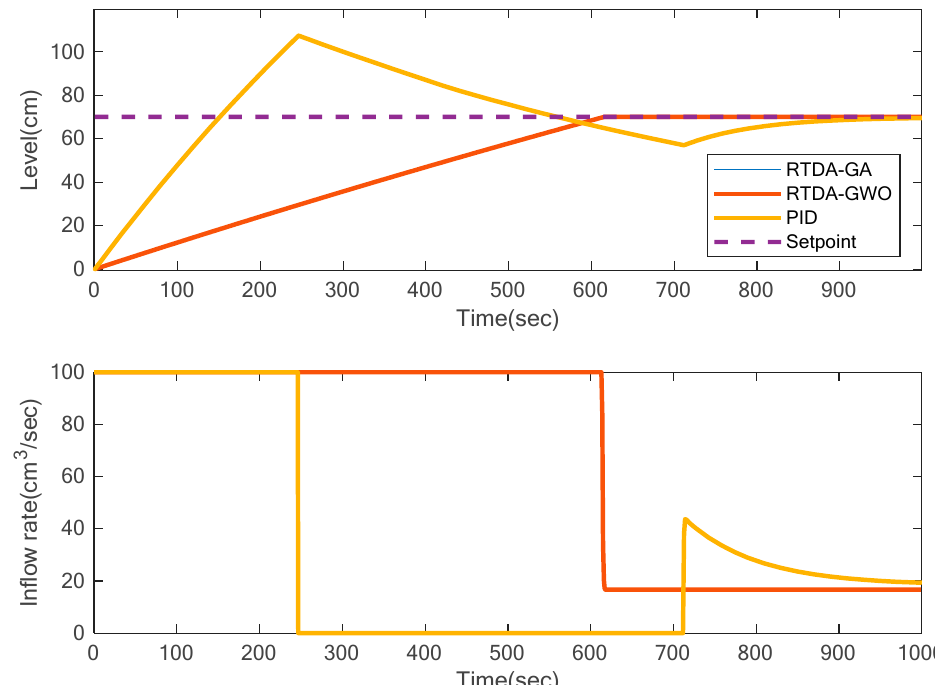
Figure 12. RTD-A and PID controlled level of conical tank for h = 70 cm. Table 9. PID parameters for level control of the conical tank.